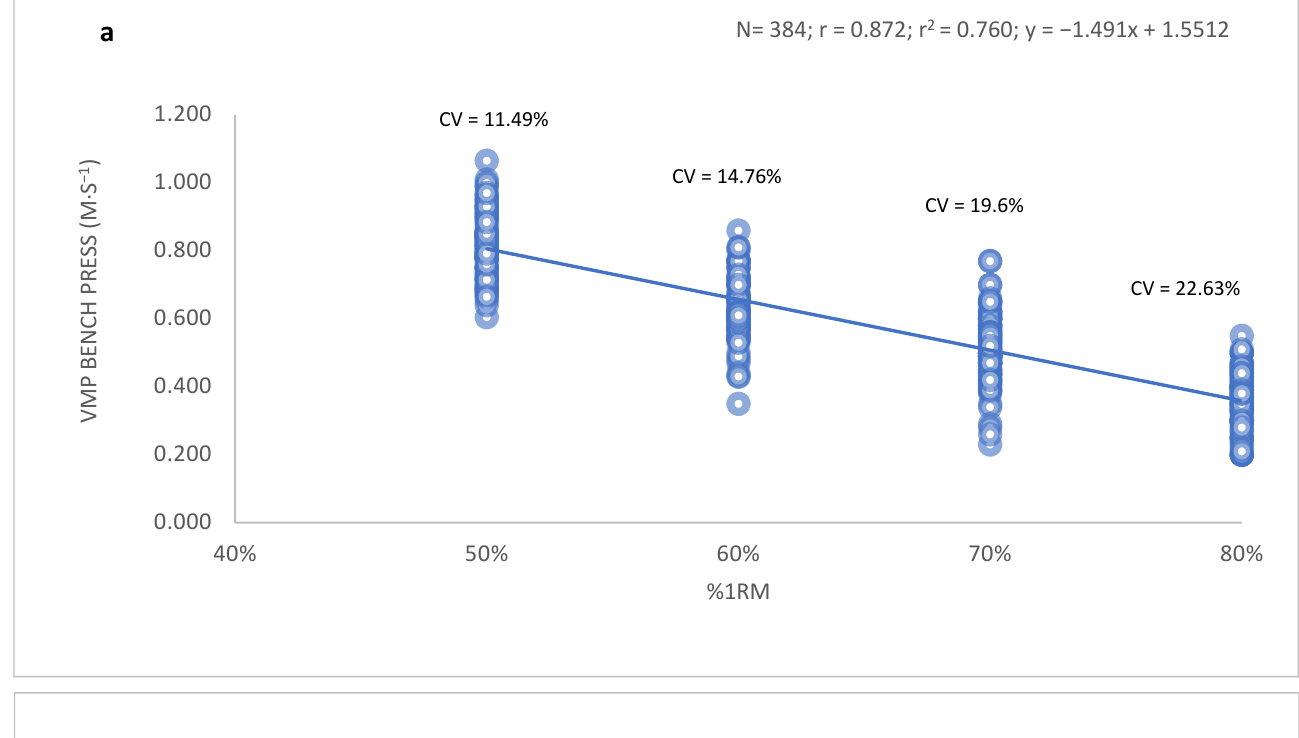
* Note. MPVSQ = mean propulsive velocity full squat; MPVBP = mean propulsive velocity bench